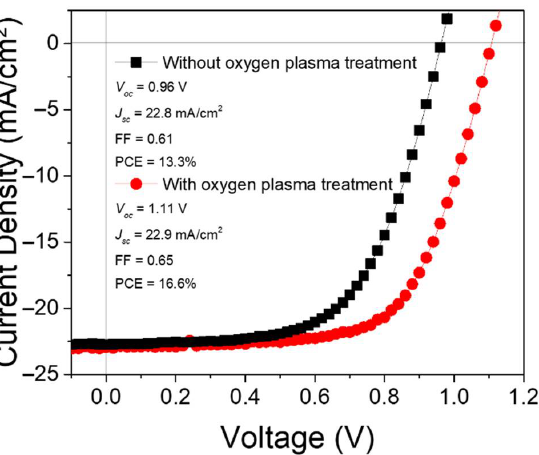
Figure 9. The J-V characteristics of the PSCs based on SnO 2 nanorod arrays with and without oxygen plasma treatment.